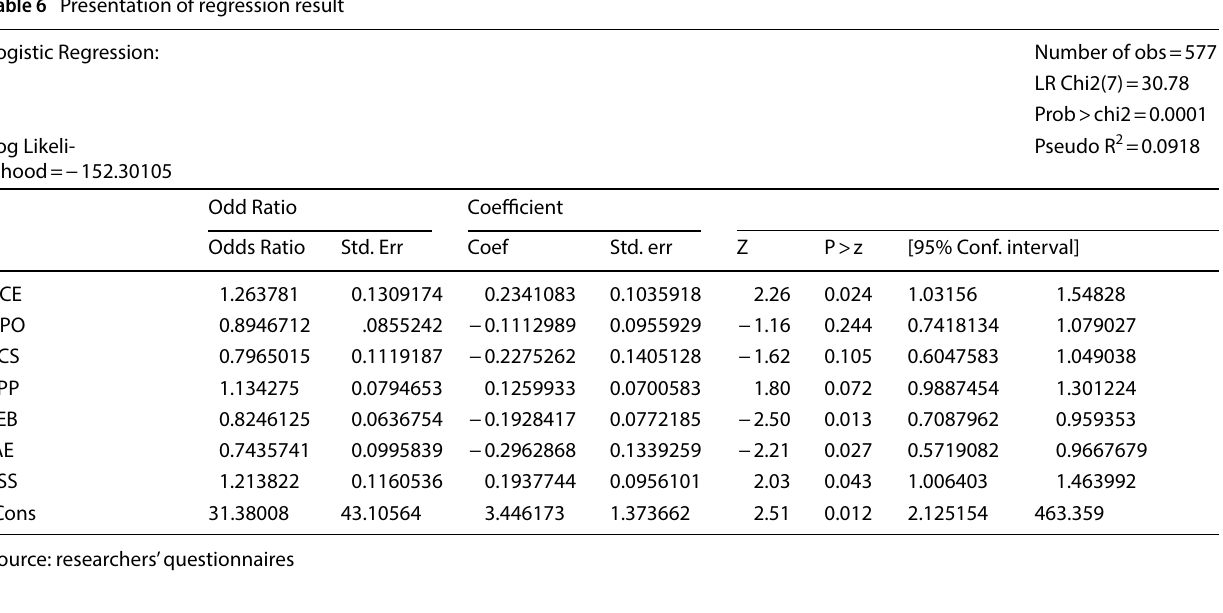
Table 7 Hosmer–Lemeshow